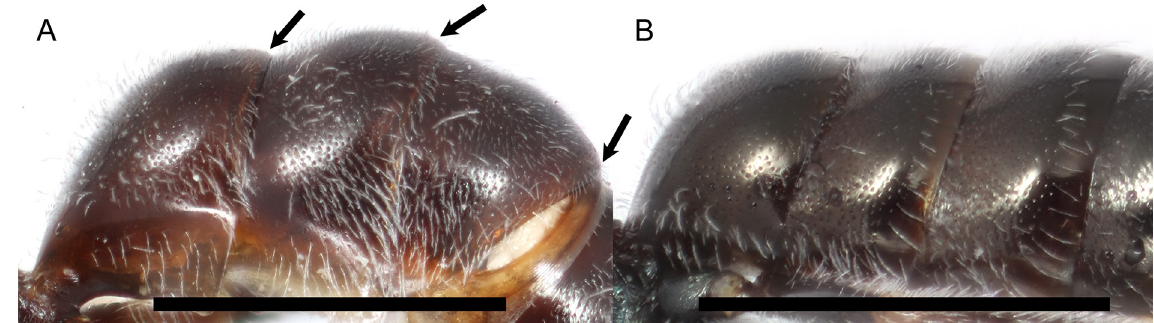
Fig. 114. T1–3. A . Lasioglossum ( D. ) cactorum sp. nov., ♂, convex with rims strongly downcurved (arrows). B . L. ( D. ) clematisellum (Cockerell, 1904), ♂, flat. Scale bars: 1 mm.